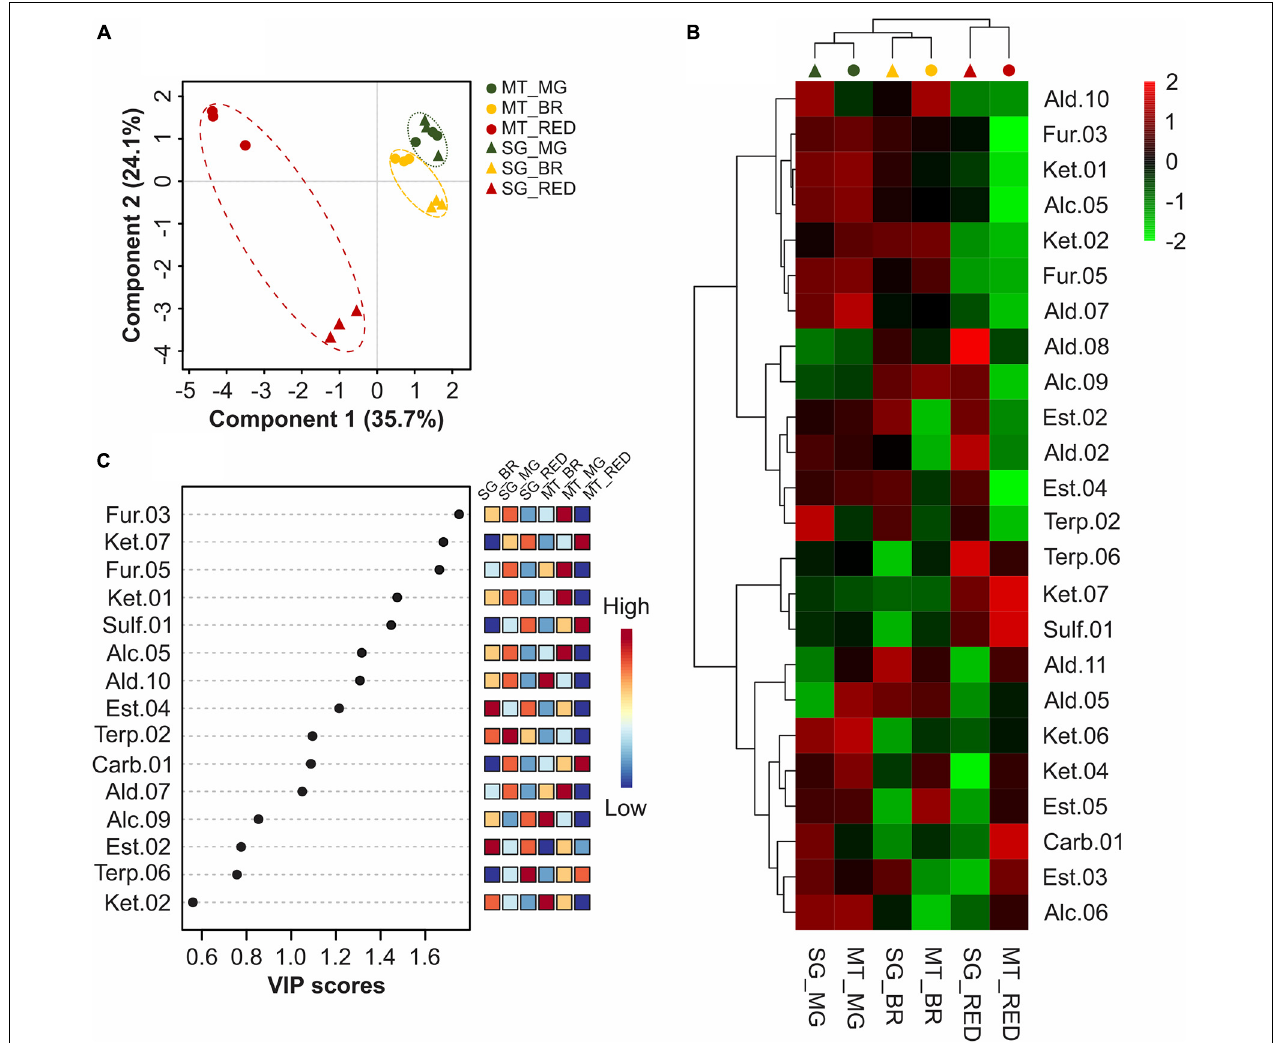
FIGURE 3 | Comparison of VOC profiles of tomato ( S. lycopersicum L.) fruits cv. Micro-Tom and Sweet Grape at mature green, breaker, and red stages. (A) Partial least squares discriminant analysis (PLS-DA). (B) Heatmap with hierarchical clustering. (C) Variable importance in projection (VIP) score plot for the TOP15 most important VOCs identified by the PLS-DA. MT, Micro-Tom. SG, sweet grape. MG, mature green stage. BR, breaker stage. RED, red stage. Each value is presented as the mean ( n =